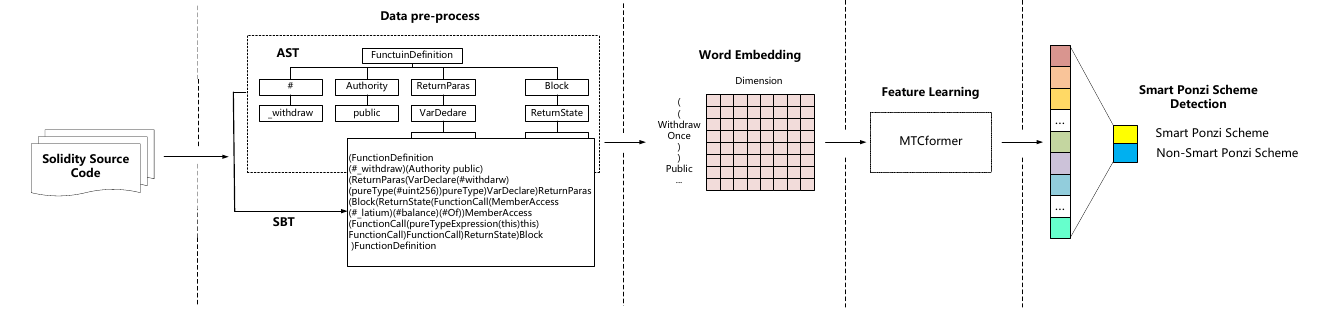
Figure 1. The overall workflow of our proposed MTCformer.